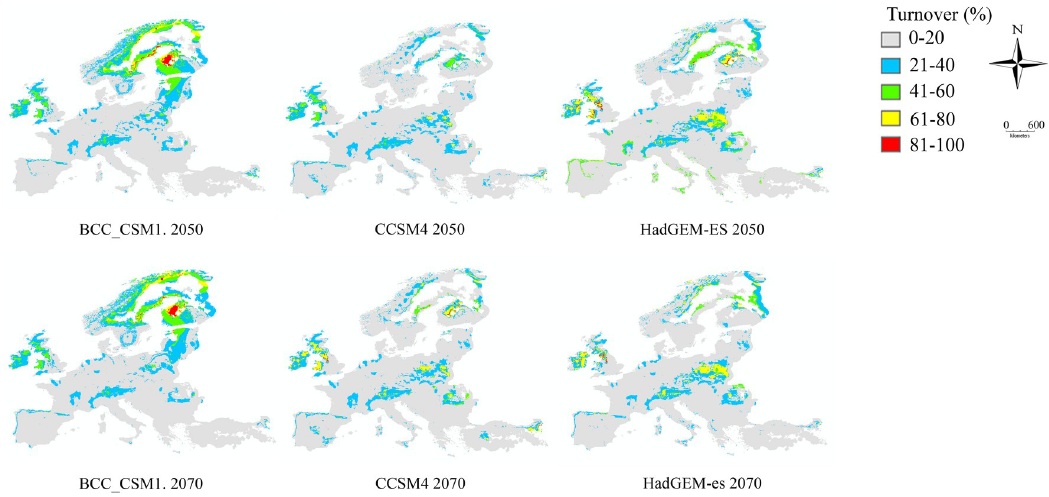
Fig 5. Percentage turnover of Pipiza species for 2050 and 2070 across all RCP scenarios based on the BCC_CSM1.1, CCSM4 and HadGEM2-ES climate models.